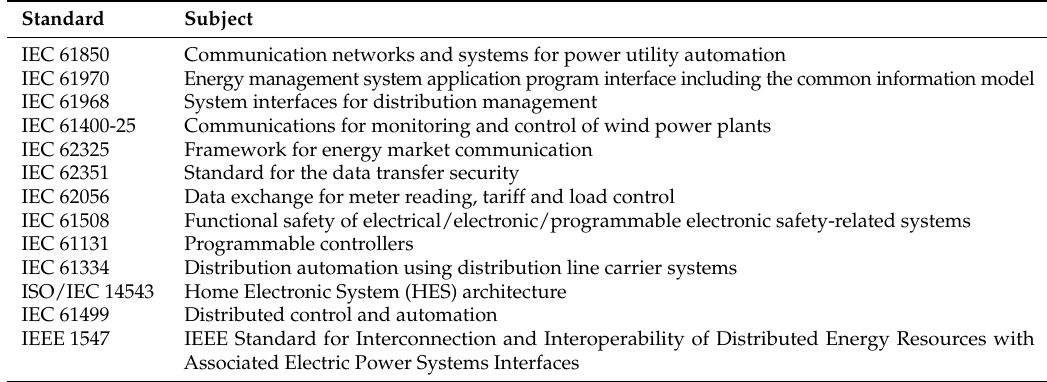
Table 3. Main communication standards for the smart